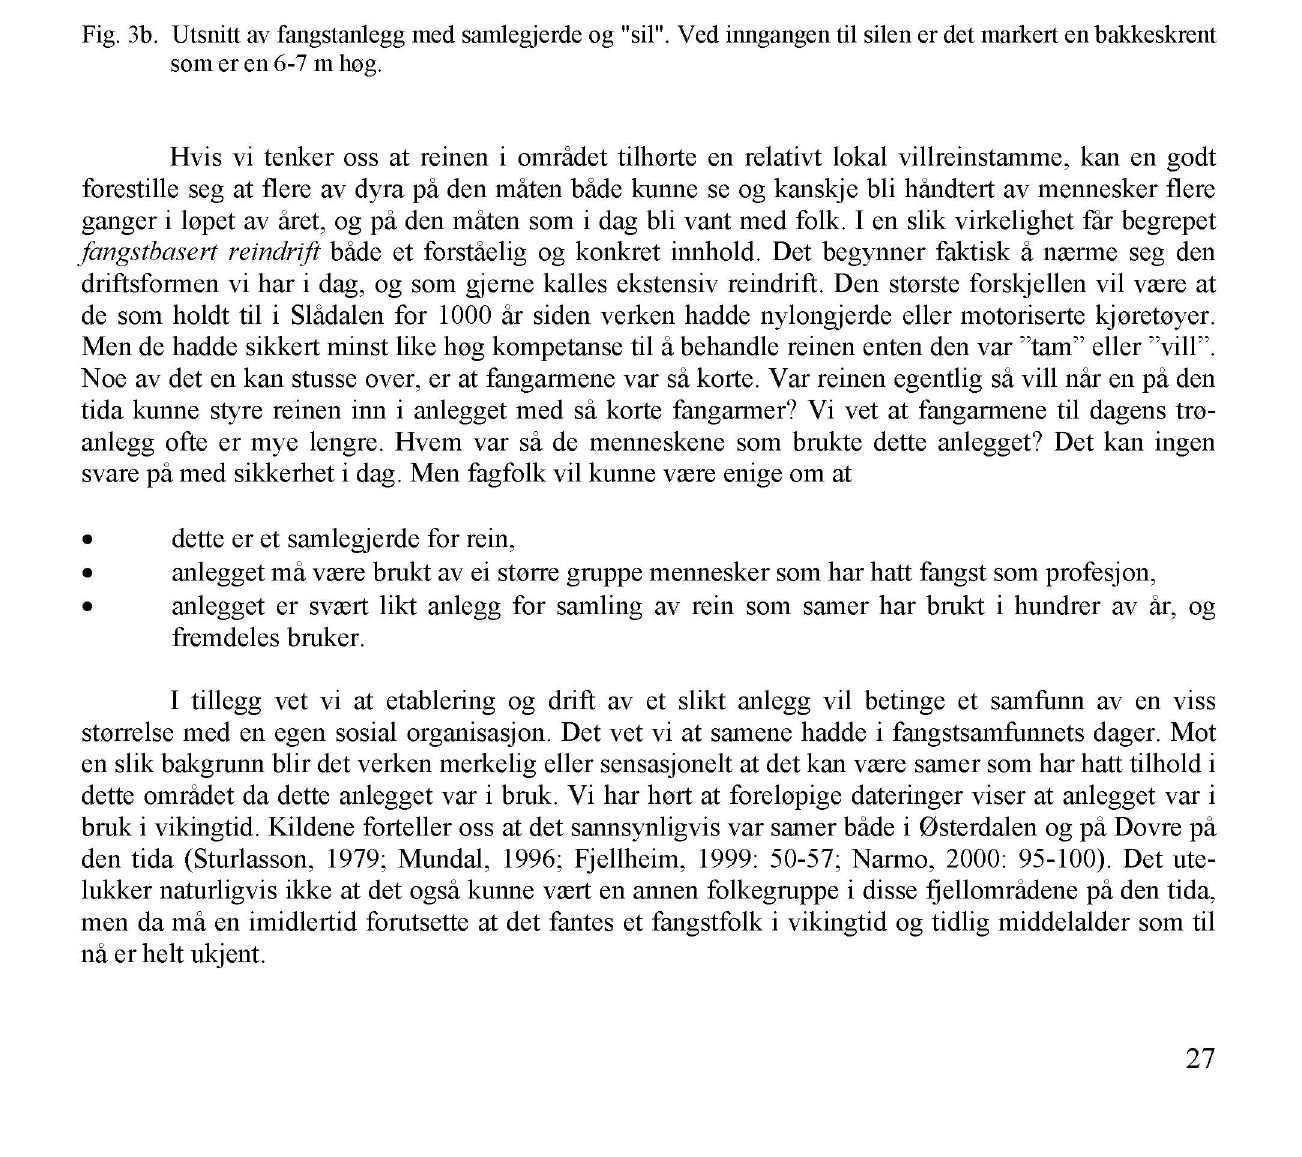
Fig. 3b. Utsnitt av fangstanlegg med samlegjerde og "sil". Ved inngangen til silen er det markert en bakkeskrent som er en 6-7 m